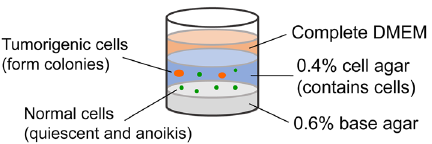
Figure 1. Schematic diagram of the soft agar colony formation assay. Cultured in a soft agar, normal cells (green color) become either quiescent or undergo anoikis, whereas malignant cells continue to proliferate and form colonies (orange